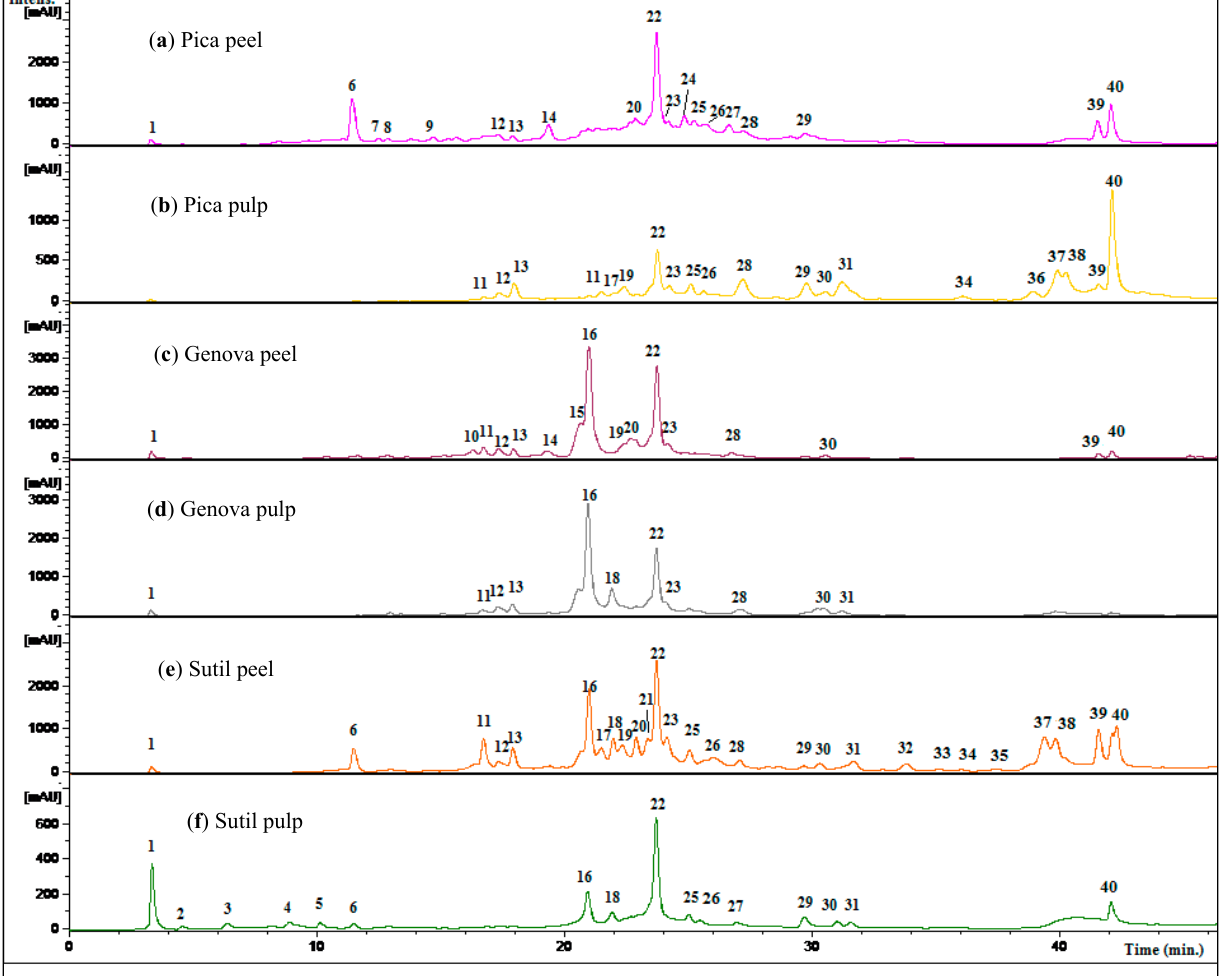
(Table 1) as well as fragmentation pattern using ESI-MS-MS experiments (key aglycone fragments of 179 and 151 for quercetin and its methyl derivatives, 257, 243 for kaempferol, 241, 175 for luteolin, 225, 201, 149 for apigenin, 151, 135 for eriodictyol and 151, 177 for naringenin) [38]. Some diosmetin, naringin, vitexin, hesperidin and their MS n fragments (Table 1) were coincident with